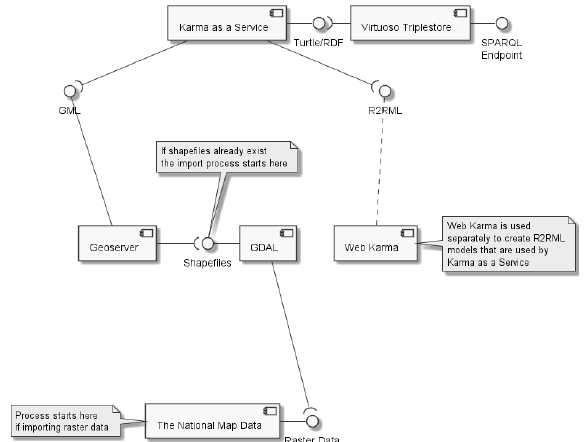
Figure 1. Workflow diagram of populating a triplestore for querying data from The National Map of the USGS. Shaded boxes indicate optional steps and bolded boxes indicate user- performed